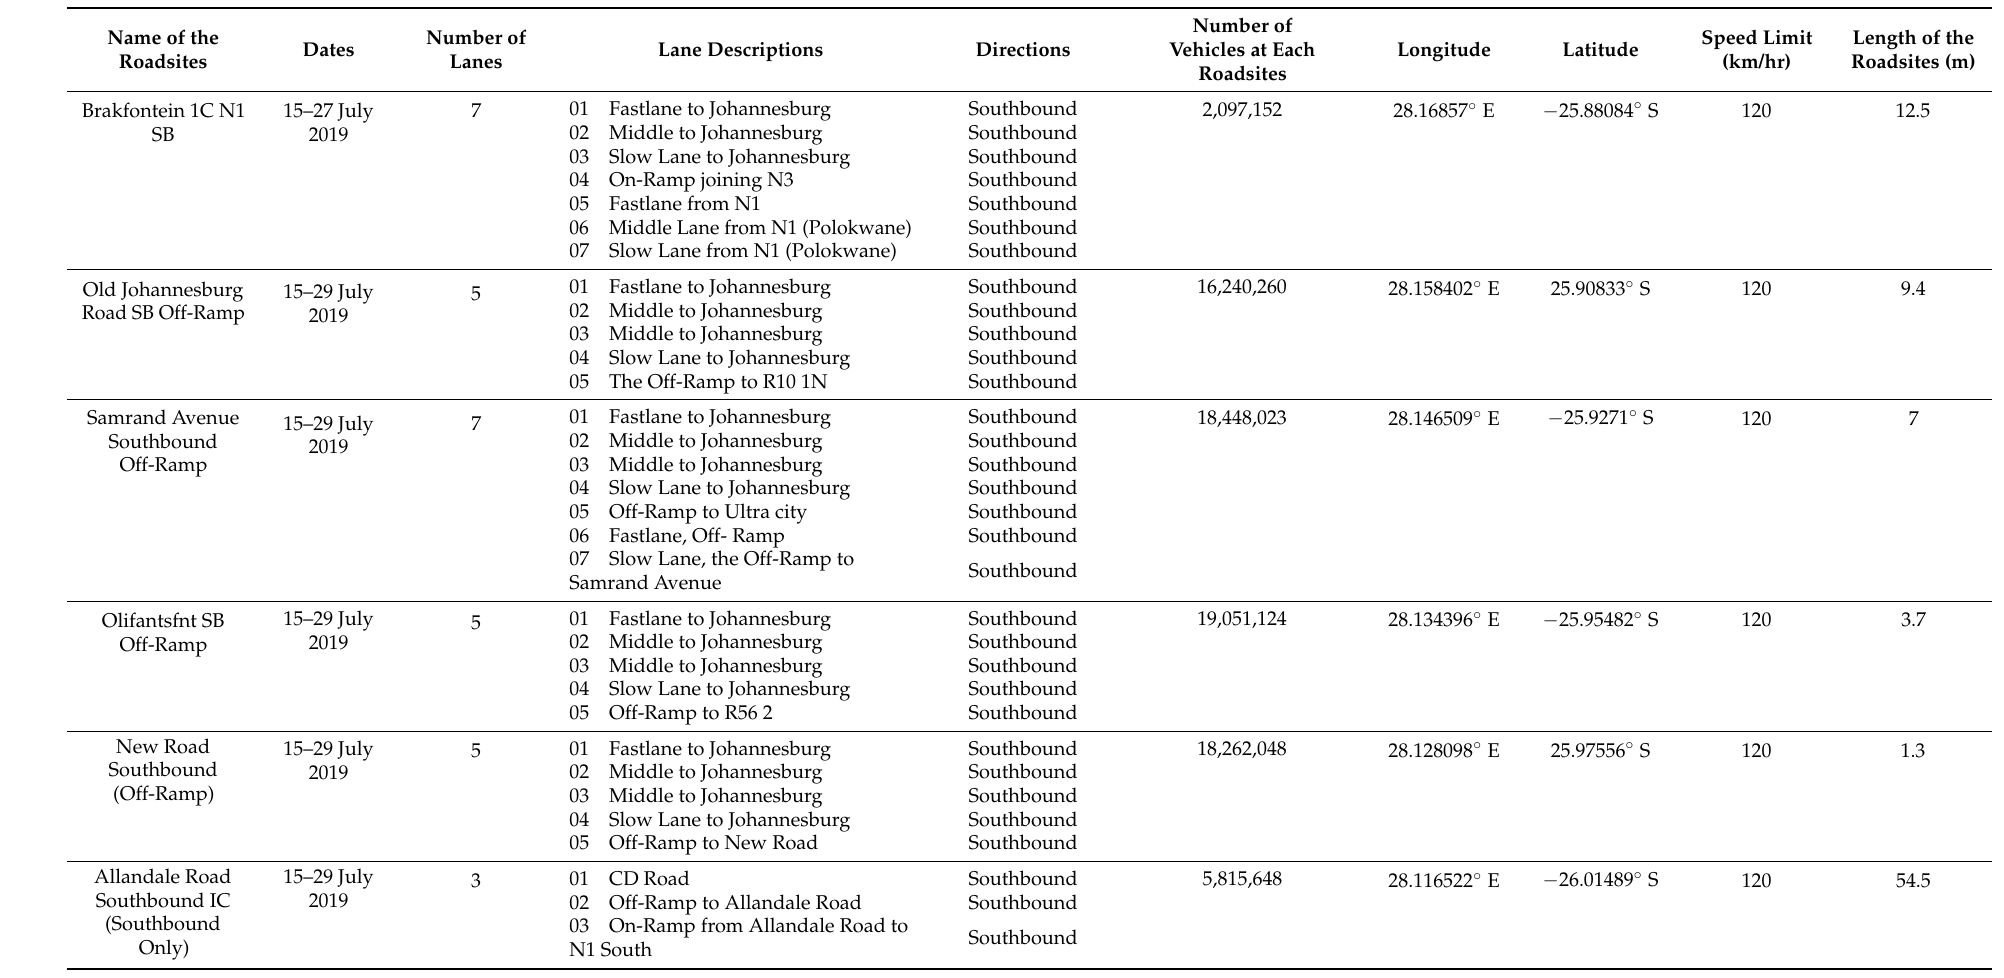
Table A1. Features of the Seven